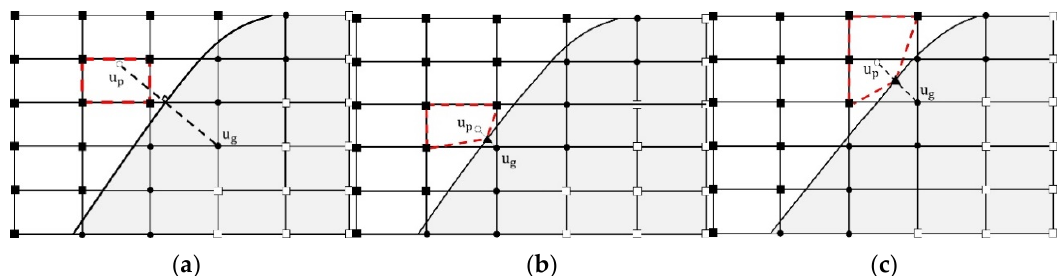
Figure 1. Uniform Cartesian grids around the immersed boundary with three types of the image points inside the rectangular cell ( a ) in the fluid without solid point, ( b ) crossed by the boundary with one solid point, and ( c ) crossed by the boundary with two solid points. The points on the stencil marked by the dashed line are used to compute the velocity u g at the ghost cells. ( • Ghost-cell forcing points; ○ Image points; Fluid points; □ Solid points; ▲ Body intercept point).